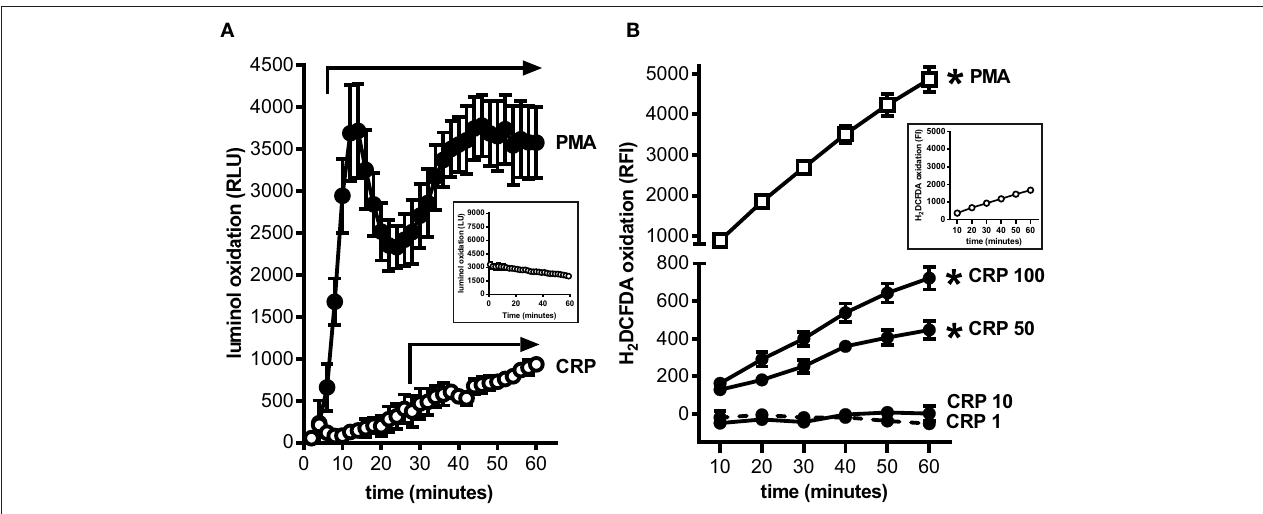
FIGURE 2 | Human CRP triggers intracellular reactive oxygen species generation by mouse MDSCs. Mouse bone marrow progenitors cultured under conditions tailored to generate MDSCs (25) were used to study the effects of human CRP on ROS generation. (A) ROS generated by BM-MDSCs stimulated with PMA (100nM) vs. human CRP (100 µ g/ml) was measured by luminol assay. PMA stimulated BM-MDSCs exhibited an initial respiratory burst followed by sustained ROS production. In contrast BM-MDSCs stimulated with CRP showed a monophasic increase in ROS with no early respiratory burst. The data shown are the mean ± SEM for three biological replicates each done with technical triplicates. The horizontal arrows begin at the first time-point when luminol oxidation (relative luminescence units, RLU, as defined in the Materials and Methods ) was significantly elevated compared to the untreated cells ( p < 0.05 for Sidak’s multiple comparisons tests; LU for untreated cells shown in the inset). (B) Intracellular ROS generated by mouse MDSCs (enriched by depletion of CD11c + cells; see the Materials and Methods and Supplemental Figure 1 ) stimulated with PMA (100nM) vs. human CRP (1–100 µ g/ml) was measured with the cell-permeant redox-sensing fluorescent dye H 2 DCFDA. Mouse MDSCs exhibited a significant increase in iROS-dependent fluorescence intensity when stimulated with 100nM PMA or high concentrations of human CRP. MDSCs stimulated with high amounts of CRP showed substantial generation of iROS. The data shown are the mean ± SEM for three biological replicates each done with five technical replicates, and the asterisks indicate p < 0.05 for Sidak’s multiple comparisons tests comparing relative fluorescence intensity (RFI, as defined in the Materials and Methods ) to the untreated cells shown in the inset.